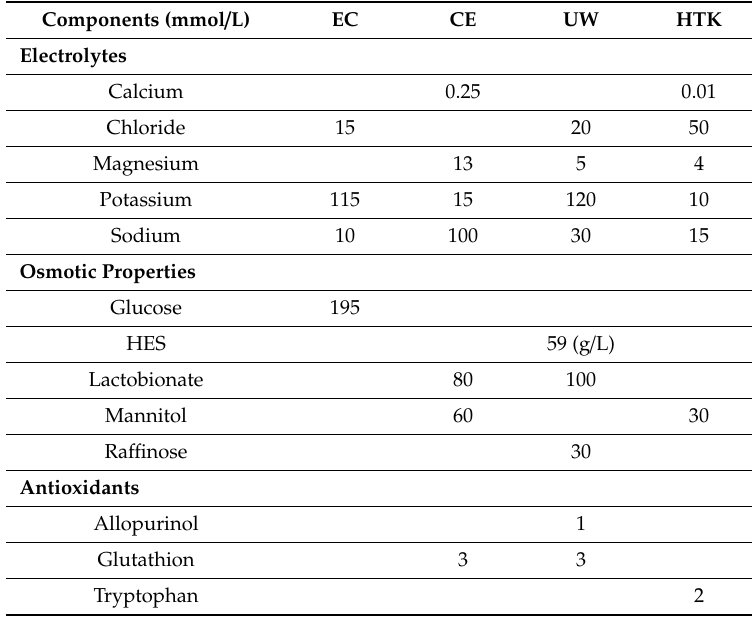
Table 1. Composition of the di ff erent preservation